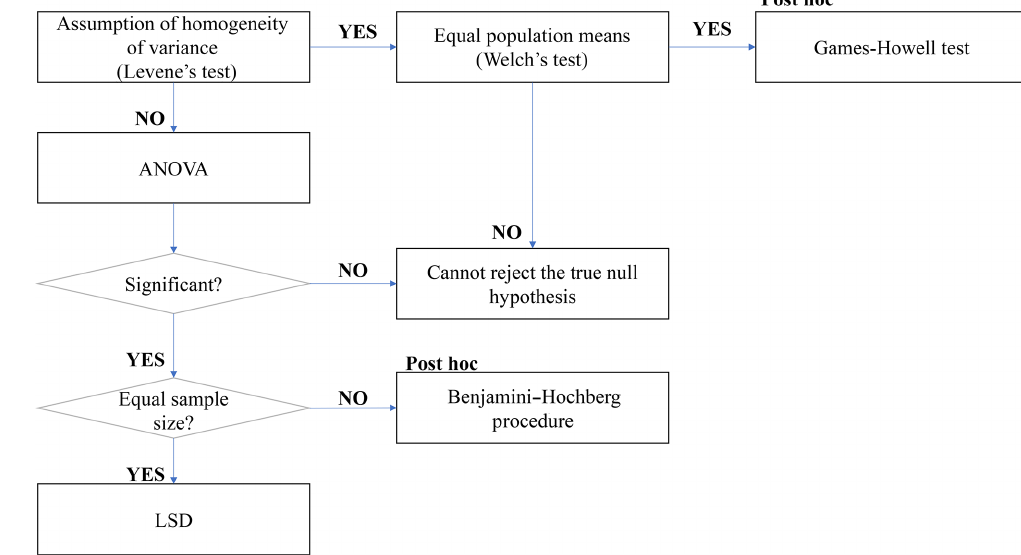
Figure 2. Overall process of one-way analysis of variance. Table 2. Sample characteristics in the pre- and postearthquake surveys.